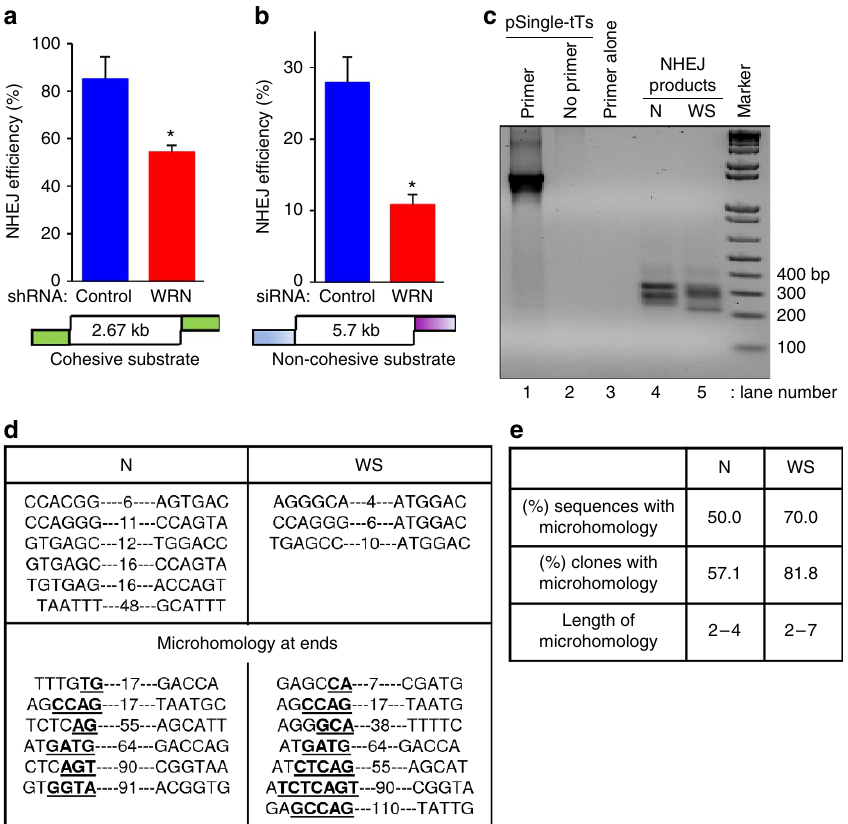
Figure 1 | WRN deficiency reduces NHEJ. ( a ) Graph indicating in vitro NHEJ efficiency of control and WRN shRNA expression HeLa cell extracts with 2.67kb cohesive-end ( Sal I-linearized) pUC18 DNA substrate. ( b ) NHEJ efficiency of U2OS cell extracts on 5.7kb non-cohesive DNA substrate derived from Bst XI-digested pSingle-tTS-shRNA plasmid. Graphs represent end-joining efficiency from three independent experiments. *, P value o 0.05. Ends of DNA substrate are colour coded to indicate cohesive (green) and non-cohesive (discontinuous blue and pink) ends. ( c ) Agarose gel showing PCR amplified products of uncut pSingle-tTS-shRNA plasmid and DNA isolated from NHEJ reactions shown in Supplementary figure 1B. Amplified bands from end joined regions can be seen in lanes 4 and 5. ( d ) Junctional sequence analysis of in vitro NHEJ products. DNA sequences of end-joined regions cloned from PCR amplified regions of NHEJ products shown in c . Numbers flanked by dashes represent number of nucleotides deleted after end joining, nucleotide sequences in bold and underlined represent microhomology sequence used for end-joining. ( e ) Table summarizing characteristics of end-joined sequences. N; SRY110010 normal lymphoblasts, WS; SRY110011 Werner syndrome patient